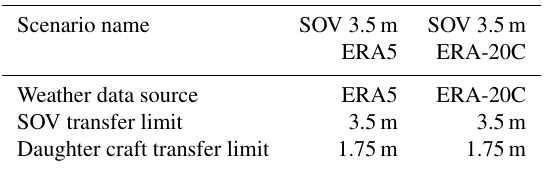
Table 4. Characteristics of the SOV scenarios simulated in this study.